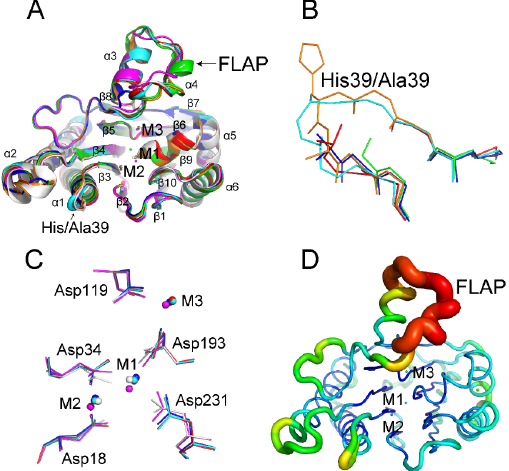
Figure 1. Analysis of tPphA structures (H39A: cyan, PDB: 5D2U. tPphA: blue, PDB: 2J82; white, PDB: 2J86_A; magenta, PDB: 2J86_B; red, PDB: 5ITI. D119A: orange, PDB: 2XZV. D193A: green, PDB: 2Y09.). ( A) The H39A structure is merged with the structures of wild ‐ type tPphA and the D119A and D193A variants. His/Ala 39 is located within a loop that is across from the FLAP subdomain. The FLAP domain adopts different conformations in different tPphA structures. ( B) The loops in which His39/Ala39 are located in different structures are merged with each other. The conformation of this loop in the H39A structure is different from those in the other tPphA structures. ( C) The catalytic center of H39A was merged with the catalytic cores of other wild ‐ type tPphAs. The positions of the three divalent cations within these catalytic centers are identical. The positions and conformations of five conserved aspartate residues in the H39A structure are the same as those in two other tPphA structures (PDB: 2J82 and 5ITI), but different from those in two monomers in a third tPphA structure (PDB: 2J86). ( D) The colors used in the figure indicate the B factor values for H39A (blue < green < orange < red). The B factor value of the FLAP subdomain is very high, which indicates that this region is very flexible.